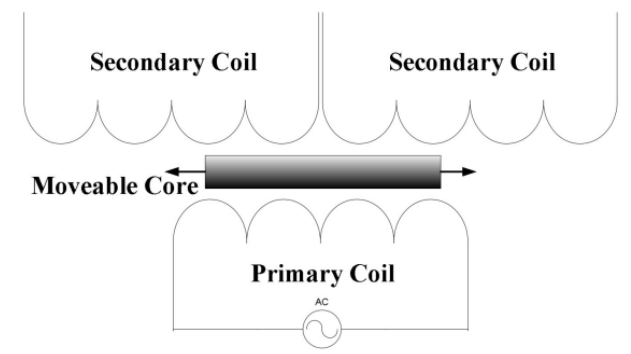
Figure 2. The working principle of LVDTs [22].